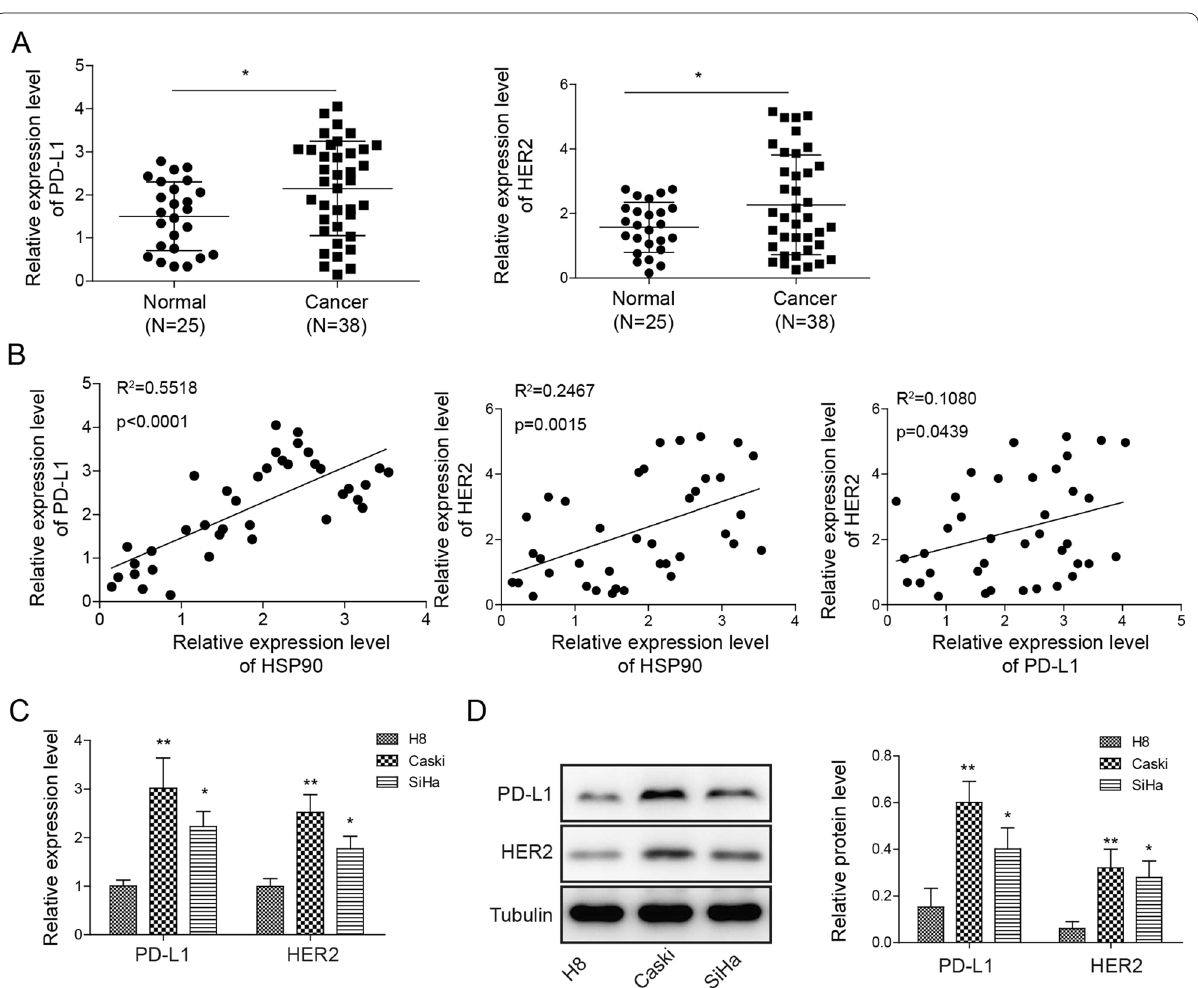
Fig. 3 Hsp90 correlated with PD‑L1 and HER2 expression in HPV16 + cervical cancer. A PD-L1 and HER2 gene expression in normal and cancer tissues. B correlation analysis among Hsp90, PD‑L1 and HER2 expression in normal and cancer tissues. C PD-L1 and HER2 gene expression in normal (H8) and cancer (Caski and SiHa) cervical epithelial cell lines. D Western blot of PD‑L1 and HER2 expression in normal (H8) and cancer (Caski and SiHa) cervical epithelial cell lines. Clinical samples: N 25 in normal tissue group, N 38 of cancer tissue group. * p < 0.05. Cell culture study: N = = each group. * p < 0.05 or ** p <